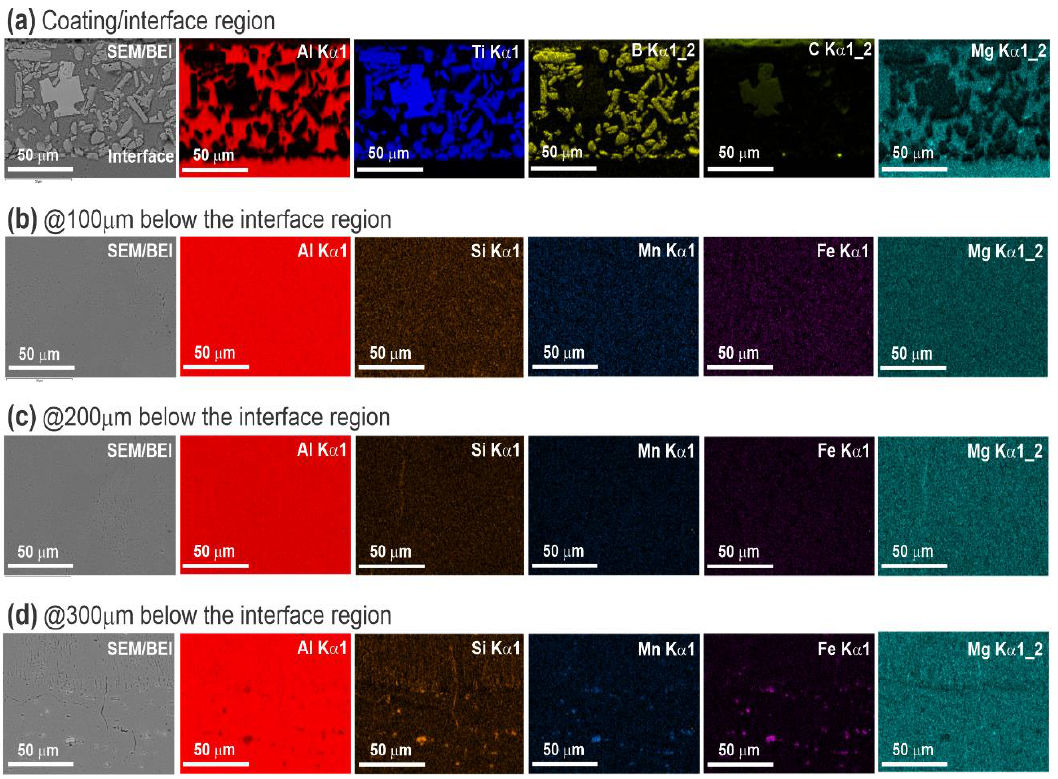
Figure 4. Cross-section EDS elemental distribution maps of the LSA TiC / TiB 2 / Al composite coating processed with LED of 20 J / mm 2 corresponding to the specific regions marked on Figure 3; ( a ) at the coating / surface interface, ( b ) 100 µ m below the interface, ( c ) 200 µ m below the interface and ( d ) 300 µ m below the interface region.